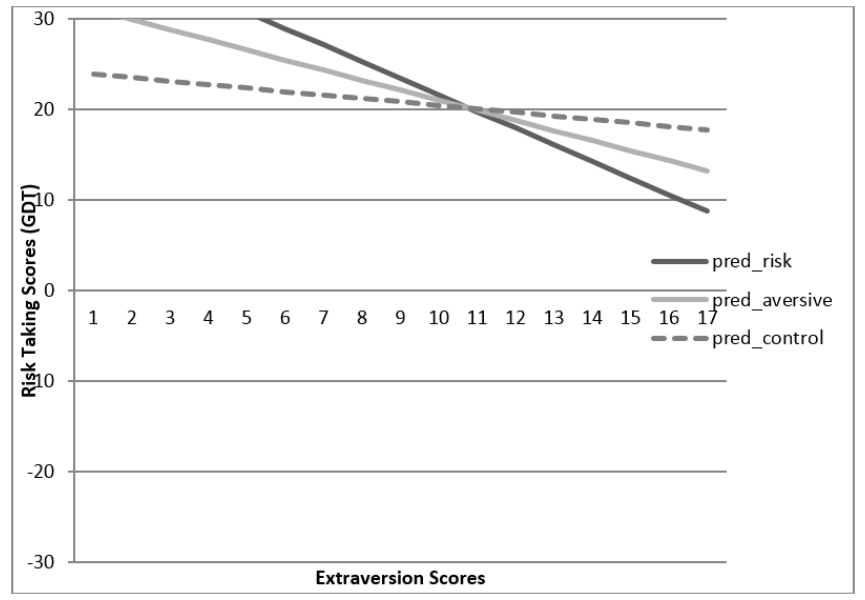
Figure 2. Extraversion as a moderator of prime & risk-taking scores in younger adults.